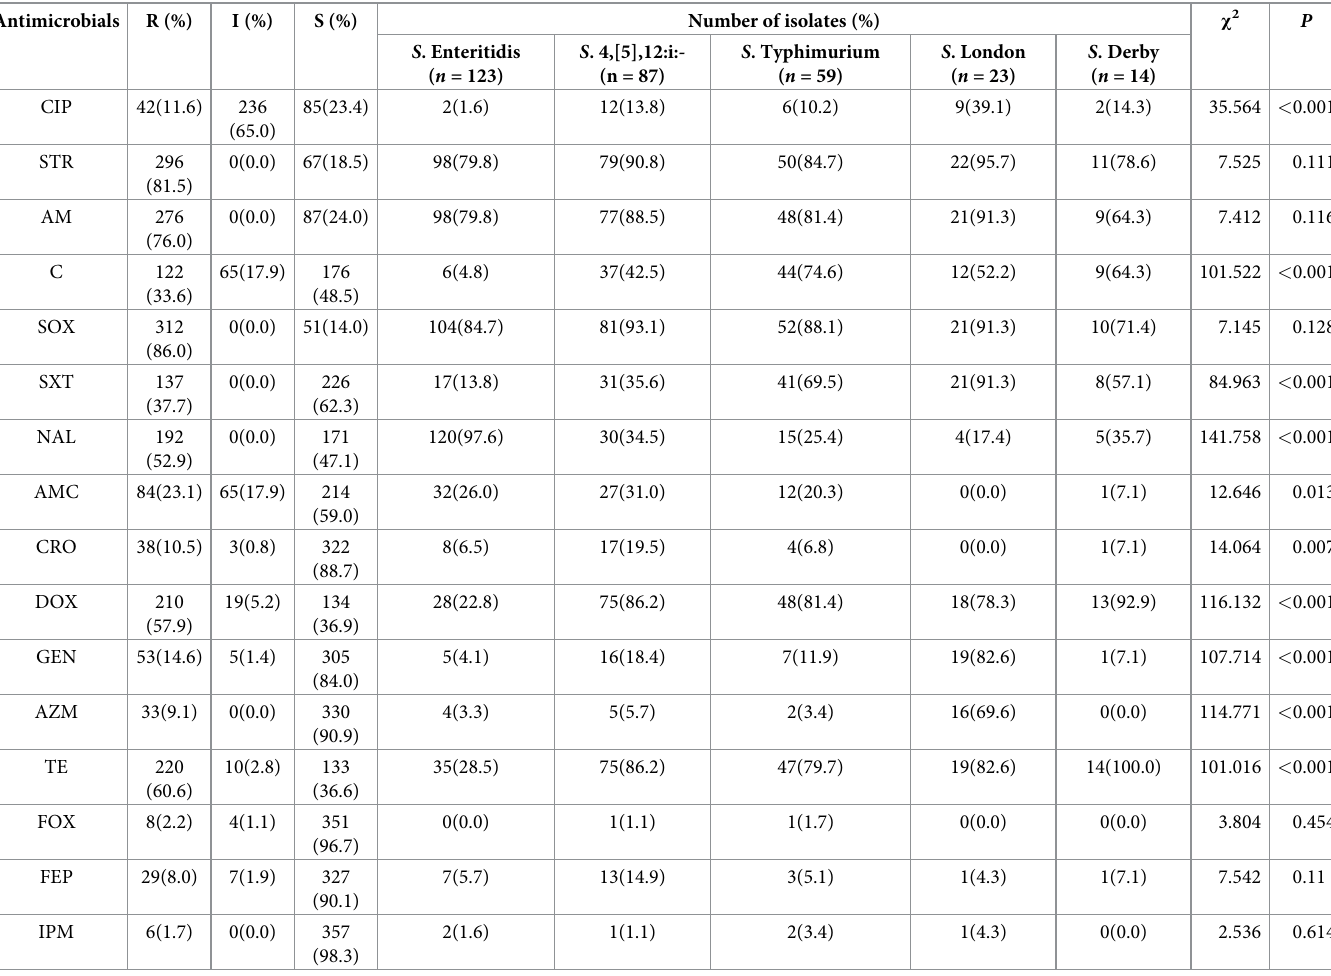
Table 2. Antimicrobial resistance of the top five Salmonella serotypes isolates from humans in Guizhou province, China, from 2013 to 2018.